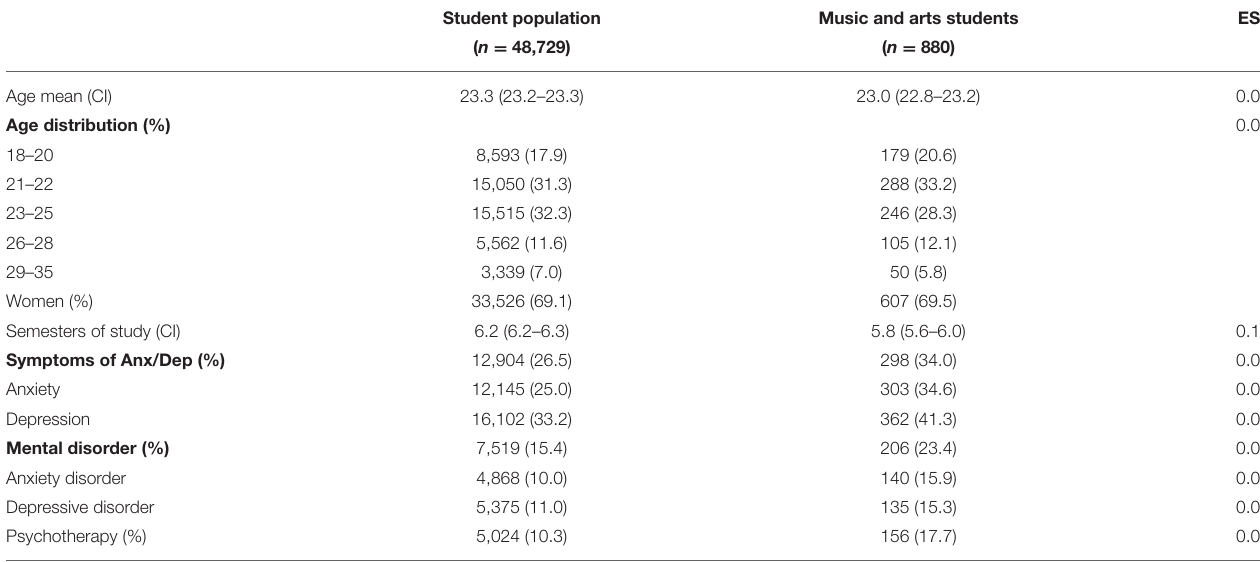
TABLE 1 | Prevalence estimates and distribution of demographic characteristics.